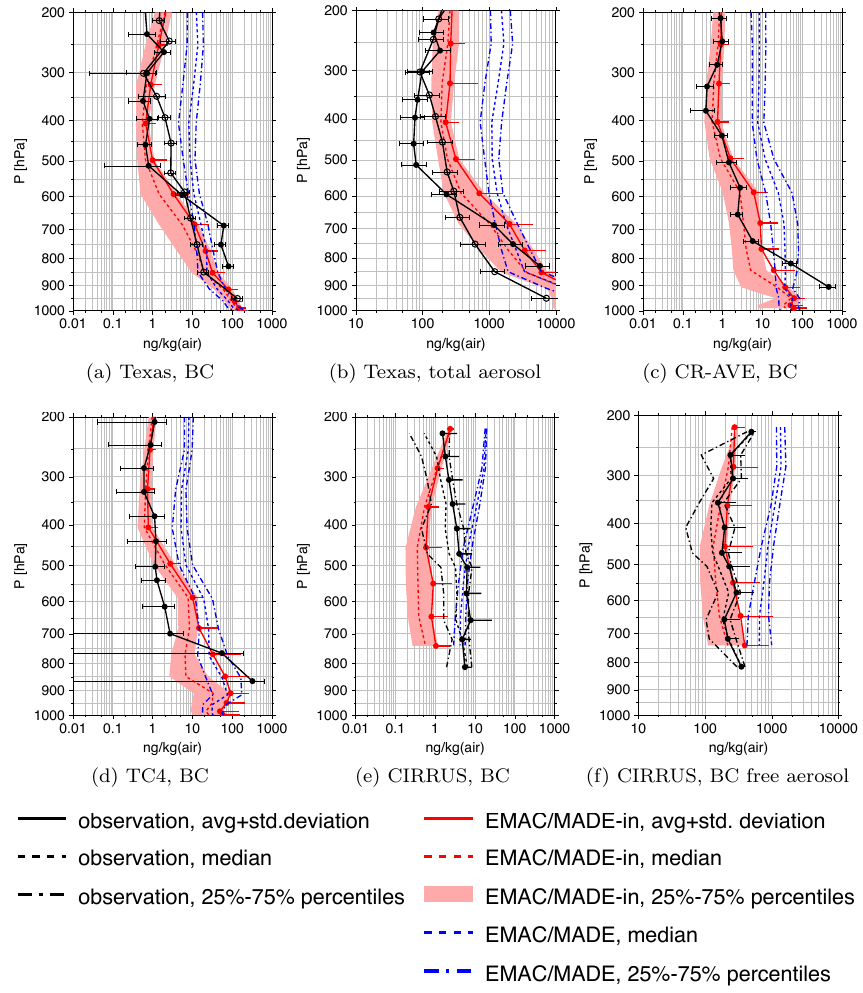
Fig. 2. Vertical profiles of BC and total aerosol mass ( a and b , respectively) measured over Texas (Schwarz et al., 2006), of BC over Costa Rica during the CR-AVE campaign ( c , Schwarz et al., 2008) and during the TC4 campaign ( d , Spackman et al., 2010), and of BC and BC free particles over Europe during CIRRUS ( e and f , respectively, Baumgardner et al., 2008) and corresponding model values of EMAC/MADE-in and EMAC/MADE. Open and solid circles in (a) and (b) correspond to two different flights. For clarity, only positive standard deviations are shown when median and percentile values are